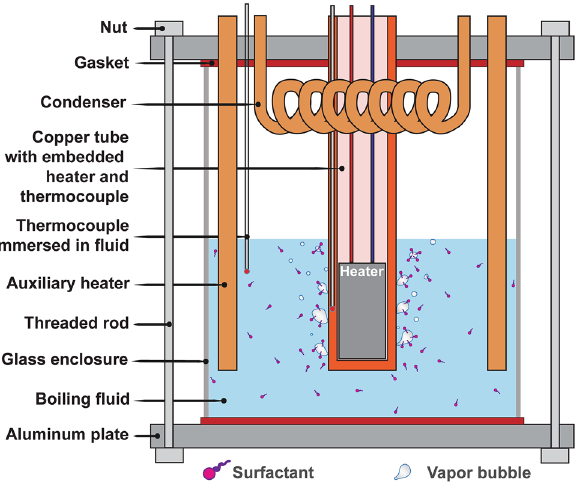
Figure 11. Schematic of the boiling setup. Two auxiliary heaters boil 300 ml of fluid to maintain a saturated temperature of ≈98 ℃ (saturation conditions in Las Vegas, NV, USA). Prior to the commencement of the boiling experiments, we degas the fluid for about 15 min. For every batch of experiments, we conduct DI water tests and gradually increase the concentration of the aqueous solution to run the tests at various surfactant